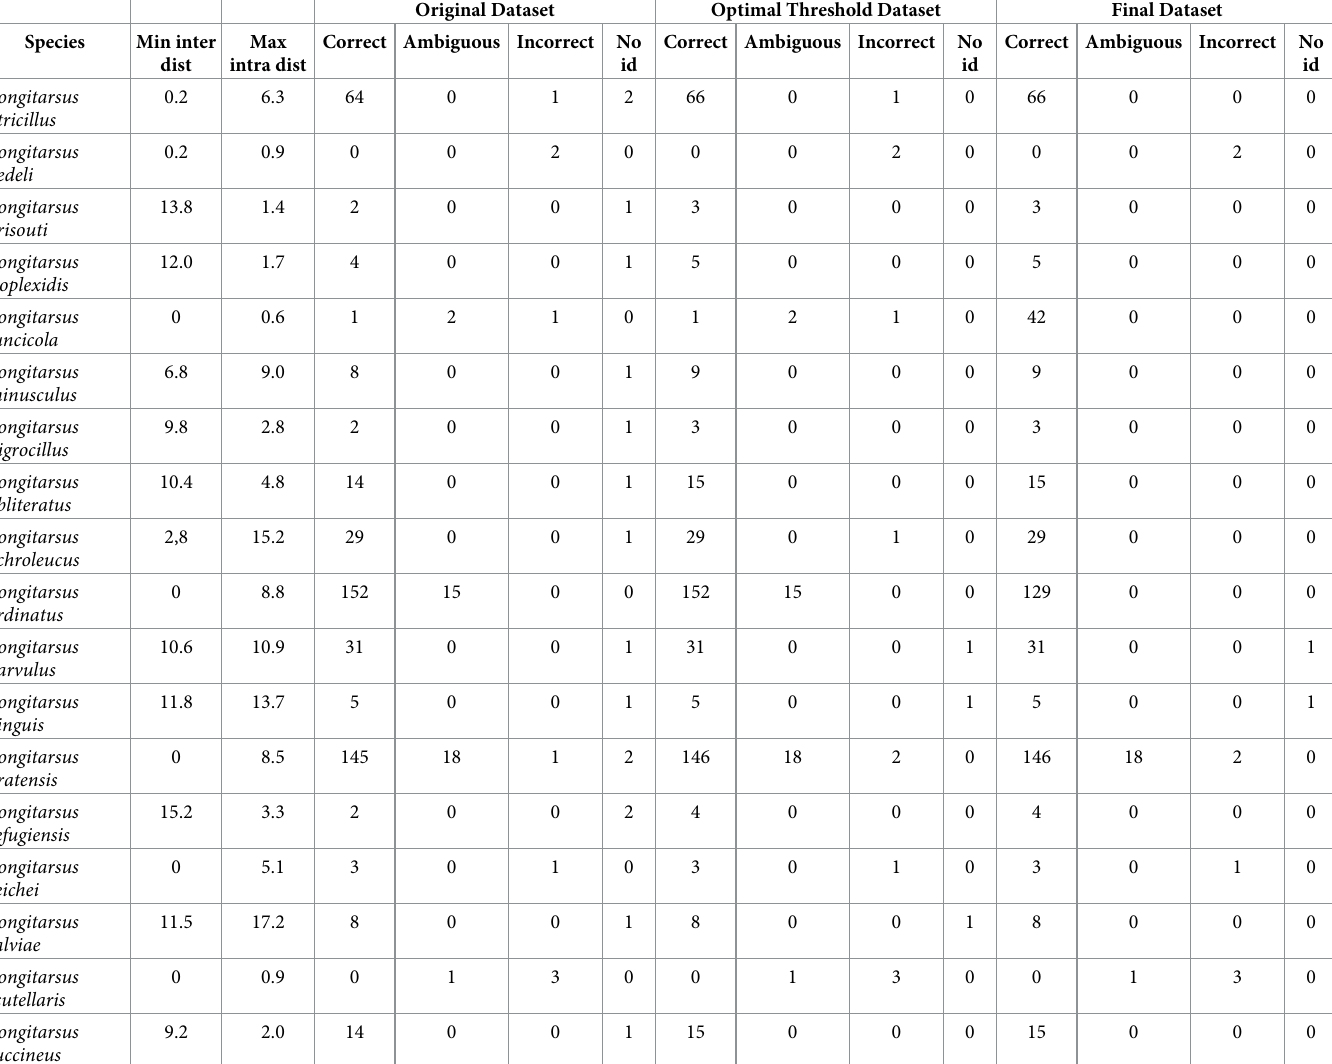
Table 1. Results of the best close match analyses. Taxonomic inconsistency for each species are reported as minimum intraspecific (Min inter dist) and maximum inter- specific (Max intra dist) genetic distance, and the number of correct, ambiguous, incorrect, and non-identify (No id) sequences, for the original dataset, the optimal thresh- olds dataset, and final